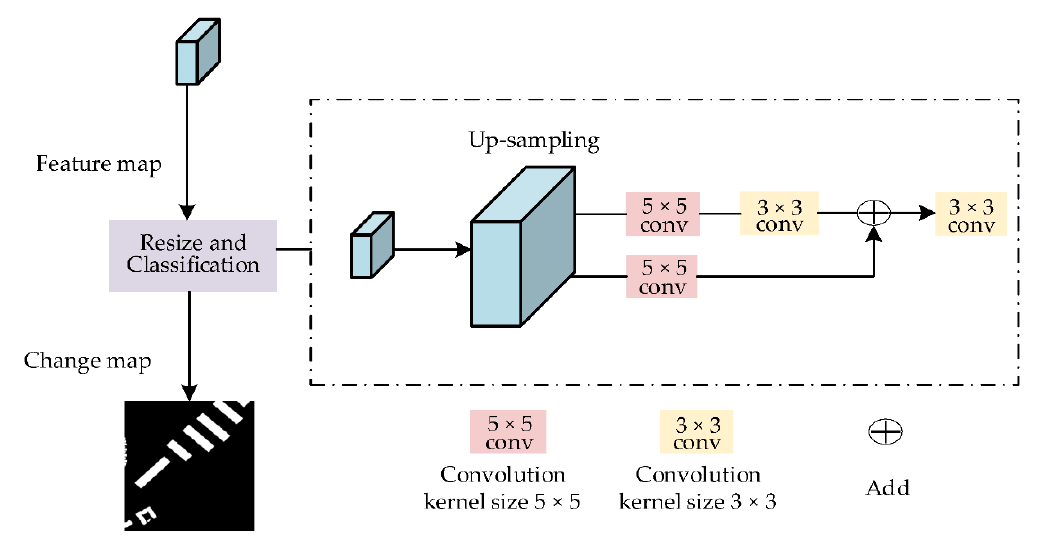
Figure 4. Classification head module.